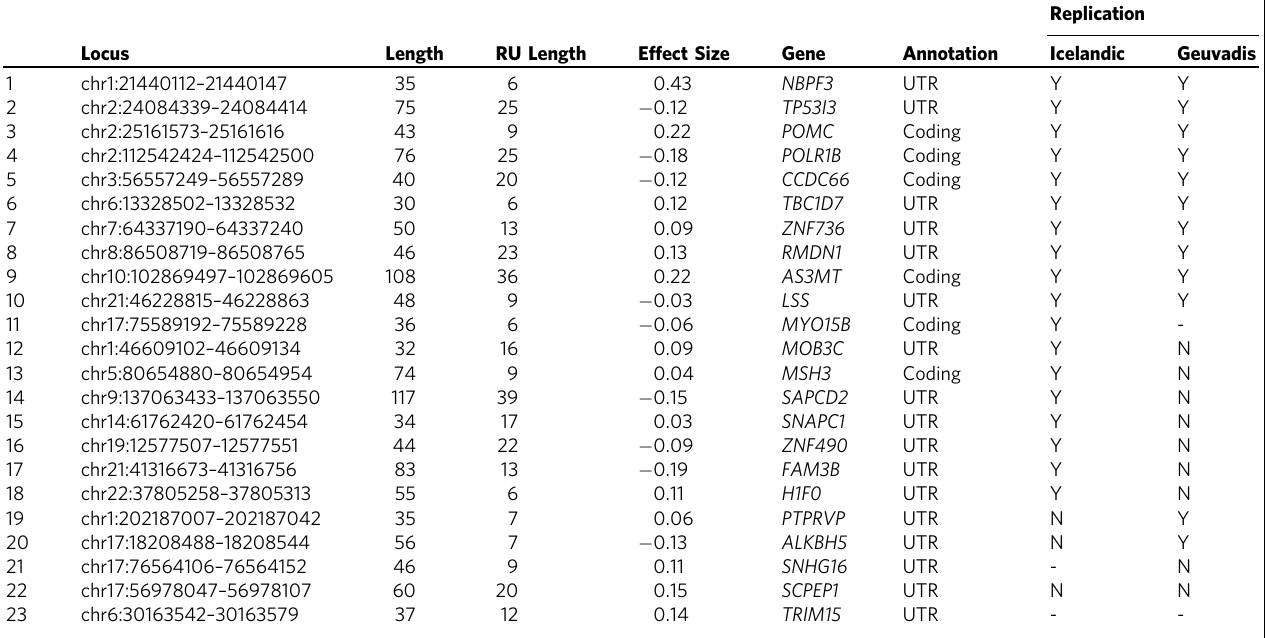
Table 1 Replication of whole blood VNTRs in independent